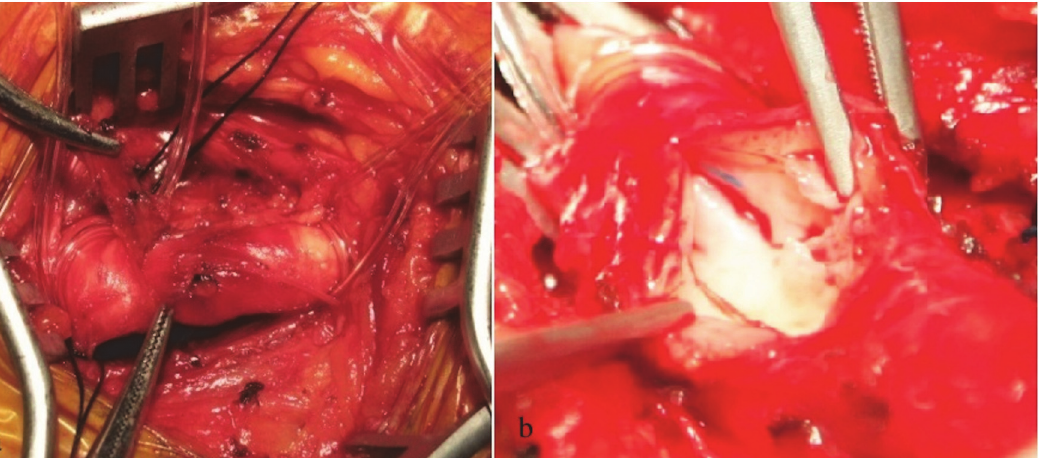
Fig 3. Open surgery at the access site. This series of photographs illustrates the twist shape of CFA when we converted to open surgery. The anterior and posterior artery walls were sutured together, and the CFA was occluded (a). The suture knot was located in the lumina (b).